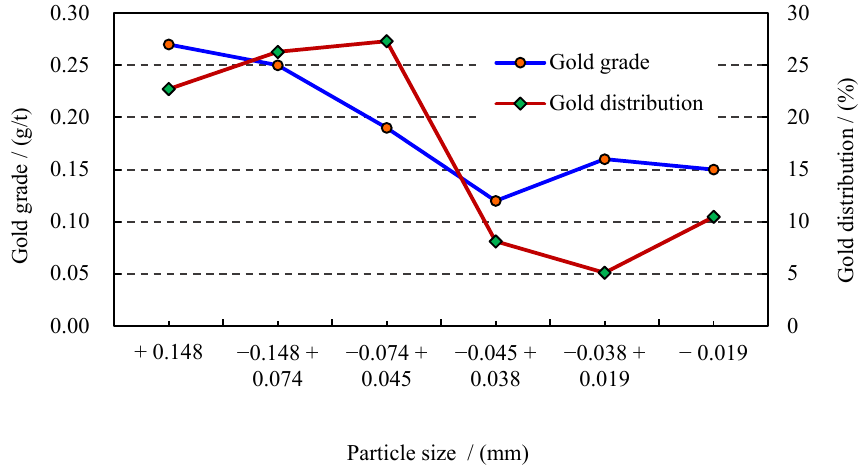
Figure 4. Particle size distributions of tailings samples and gold distribution depending on size.